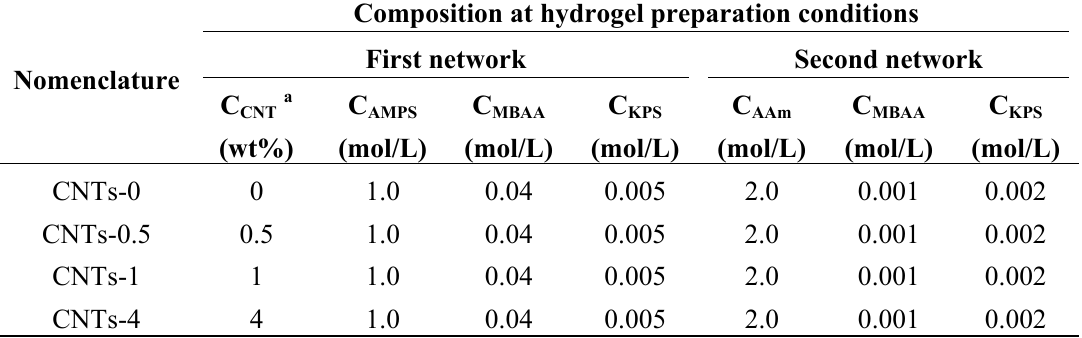
Table 4. Nomenclature and composition of nanocomposite DN